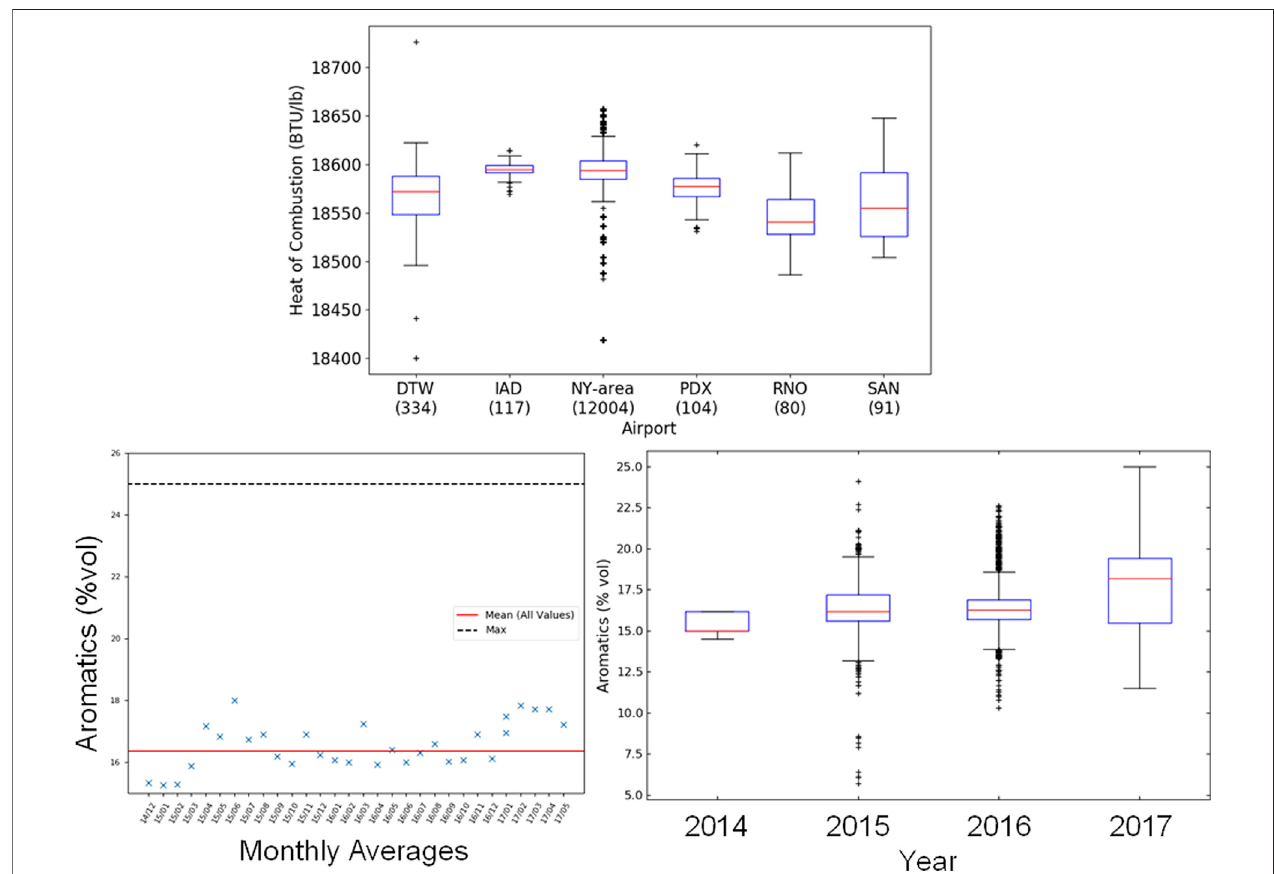
FIGURE 8 | Collated data from the U.S. Domestic Airport data sampling program, METRON – change in fuel properties by airport, over time (single year) and long term trends.